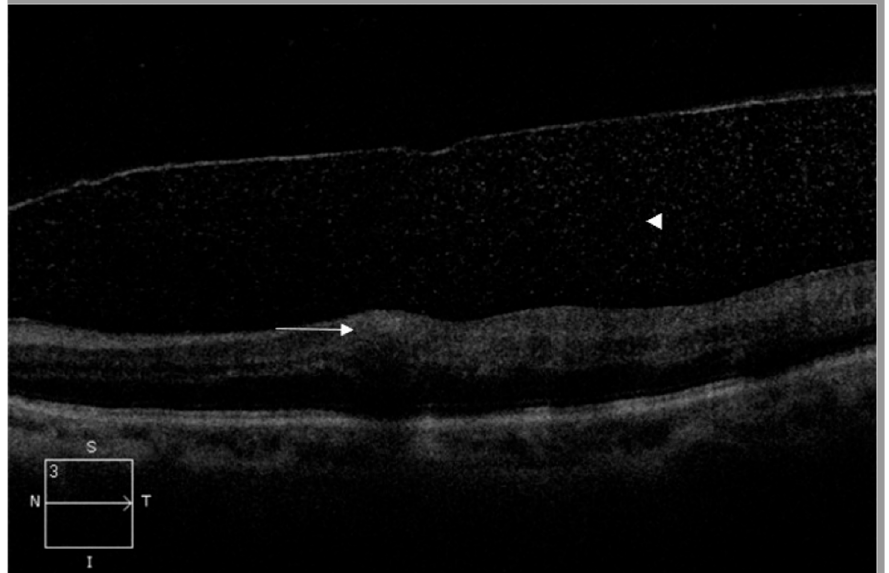
Figure 3. Optical coherence tomography image of the left eye demonstrating superficial retinal hemorrhage (white arrow) and dense pre-macular hemorrhage (white arrowhead).